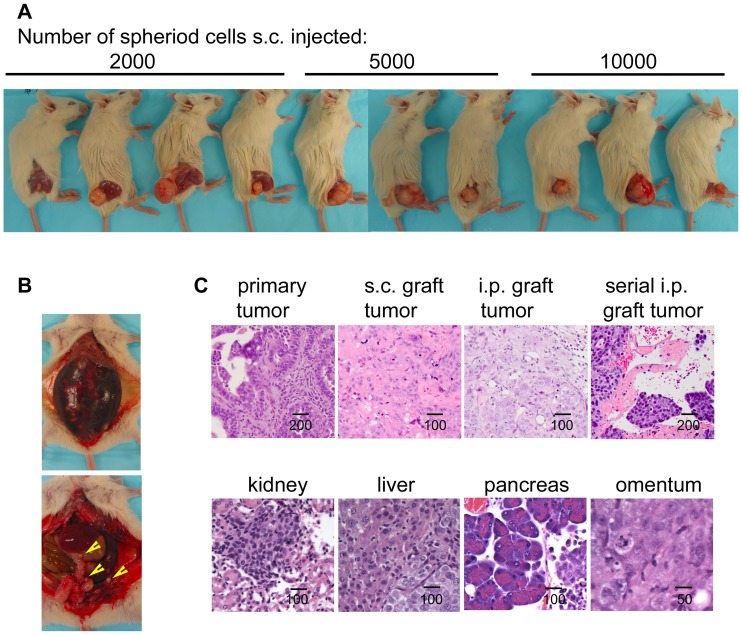
RP-OV17534 Spheroid cells generated tumors in immune-deficient mice.(A) Different amount of spheroid cells s.c. injected into SCID mice formed tumors. (B) Spheroid cells i.p. injected into SCID mice formed bloody ascites and tumors in different organs as indicated by arrows. (C) Representative H&E staining sections (upper panel) shows RP-OV17534 primary tumor, subcutaneous graft tumor from spheroids, intraperitoneal graft tumor from spheroids, and serial intraperitoneal graft tumor from SCID mouse ascites. Histological analysis (lower panel) shows frequent metastasis of tumor cells into various organs of spheroid cells recipients.